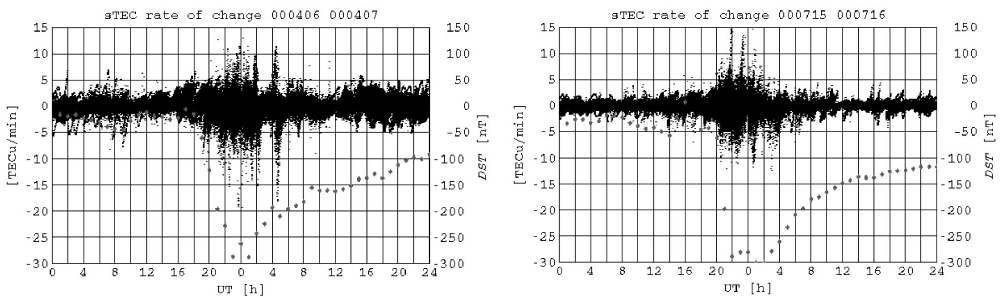
Fig. 18.6. sTEC rate of change with dt = 1 min for April 06-07 and for July 15-16. Data extracted every 1 min. Dst index values are also plotted.